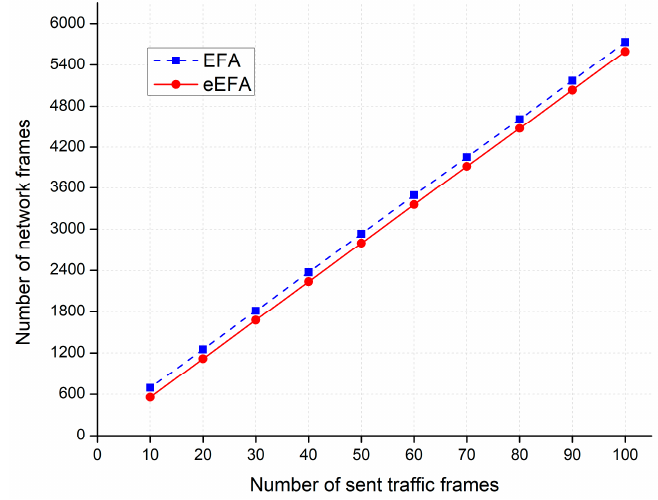
Figure 11. Result of Simulation 2.